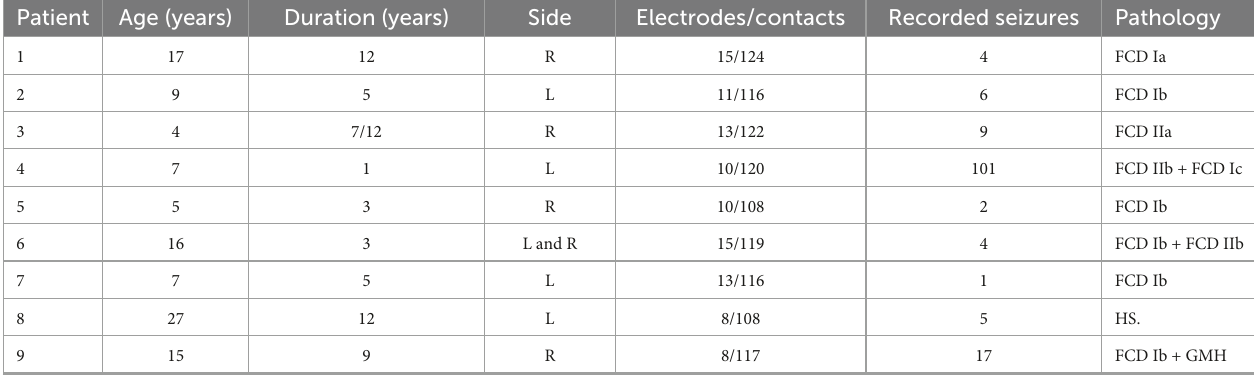
TABLE 1 Clinical patient